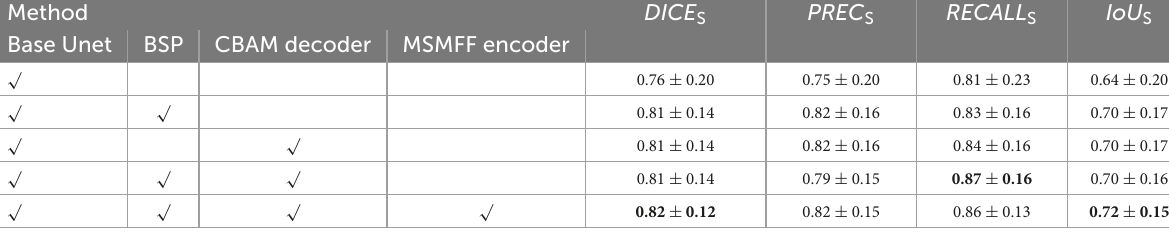
TABLE 4 Nasopharyngeal carcinoma segmentation results of ablation experiments. Method DICE S Base Unet